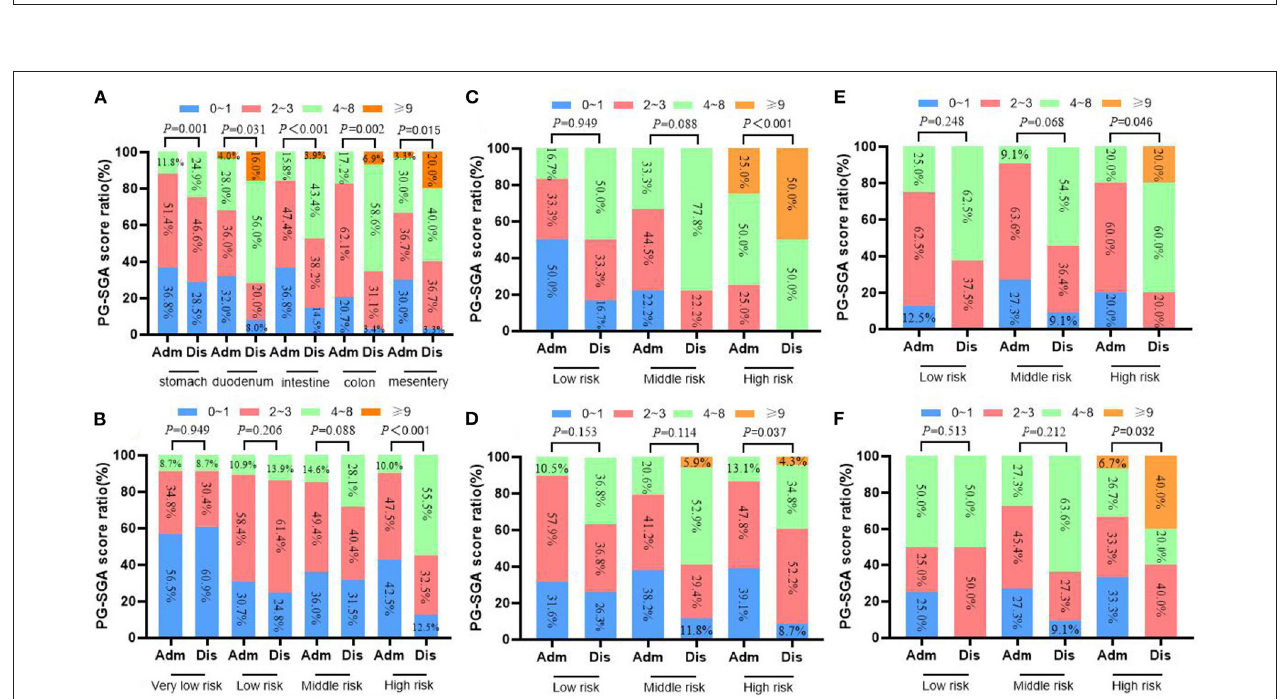
FIGURE 3 | Changes of PG-SGA nutritional assessment in 413 GIST patients at admission and discharge. (A) Total; (B) stomach; (C) duodenum; (D) intestine; (E) colorectal; (F) mesentery.